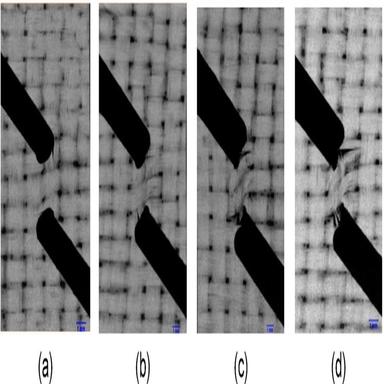
Reconstruction image: (a) Step 4; (b) Step 5; (c) Step 6; (d) Step 7.